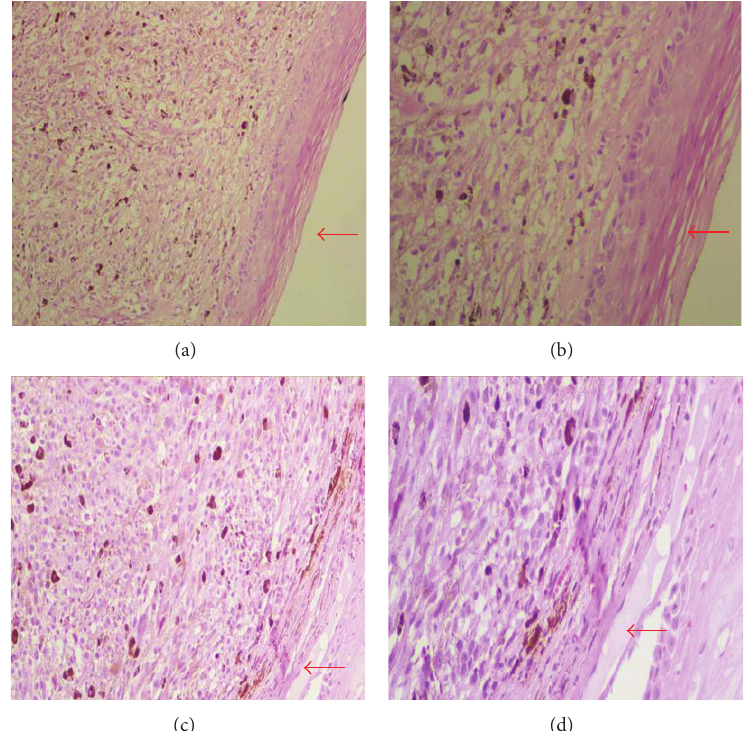
Figure 2: Tumor and vaginal epithelium. The arrows in (a, b) point the squamous cell epithelium of the vagina. The arrows in (c, d) point out the ulceration that tumor caused in the vaginal epithelium (H&E (a, c) × 200, (b, d) × 400).